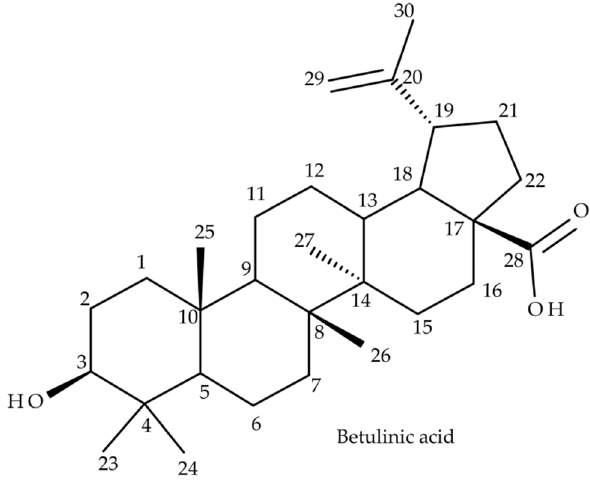
Figure 1. Chemical structure of betulinic acid (BA) (3 β , hydroxy-lup-20(29)-en-28-oic acid).